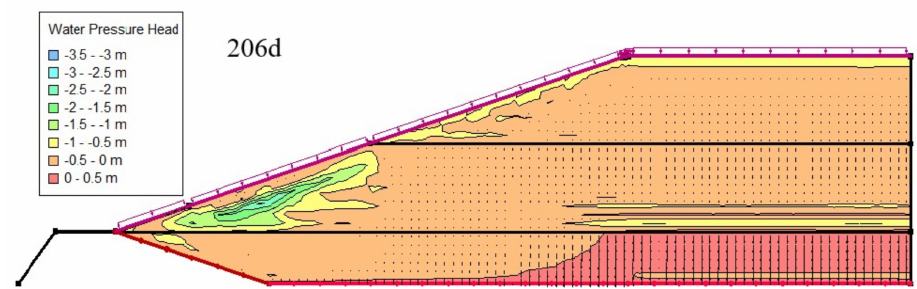
Figure 5. Leachate distribution within a landfill with the condition of no